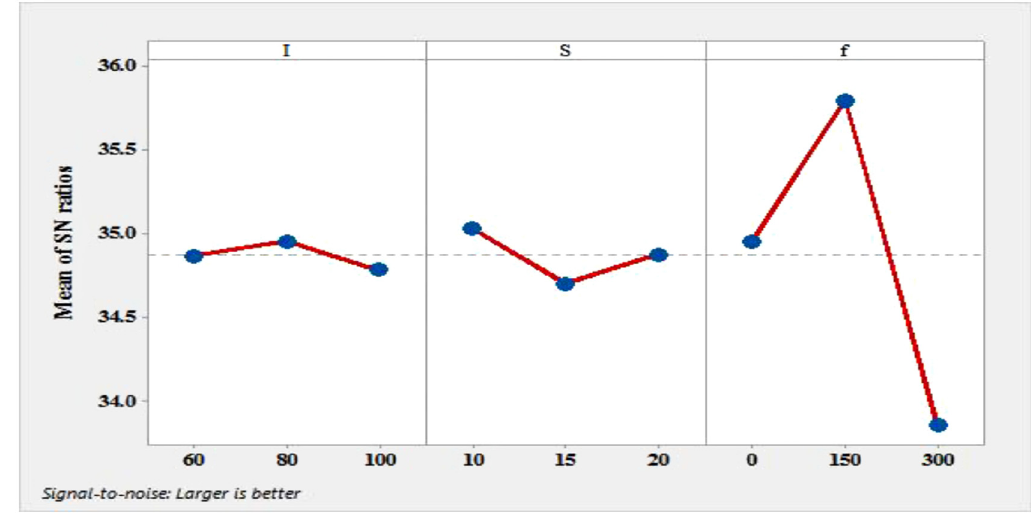
Fig. 4. Main effect plot of S/N ratio of Impact strength for L 9 OA. Table 8. Analysis of variance for impact strength of L OA. 9